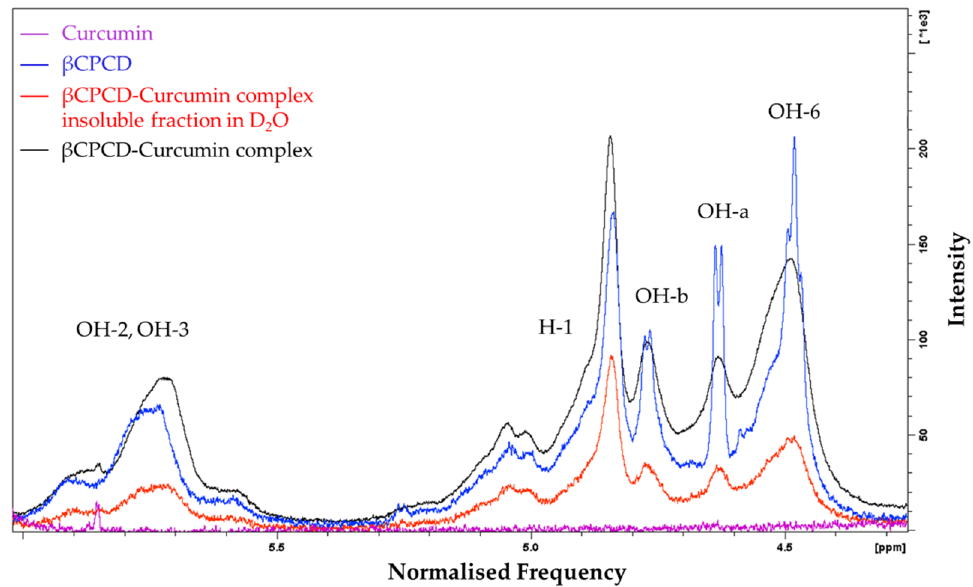
Figure 4. Comparison of 1 H NMR spectra in DMSO-d 6 of curcumin (purple), β CPCD (blue), insoluble fraction in D 2 O of β CPCD–curcumin mixture (red) and β CPCD–curcumin mixture (black) at 6.00–4.30 ppm .